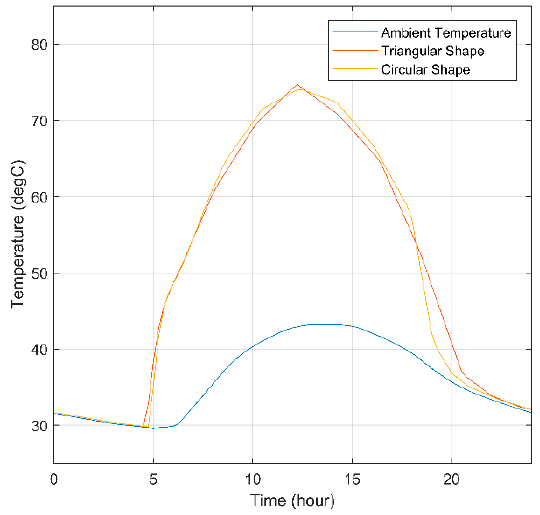
Figure 13. Midpoint temperature for different shapes of SHC.